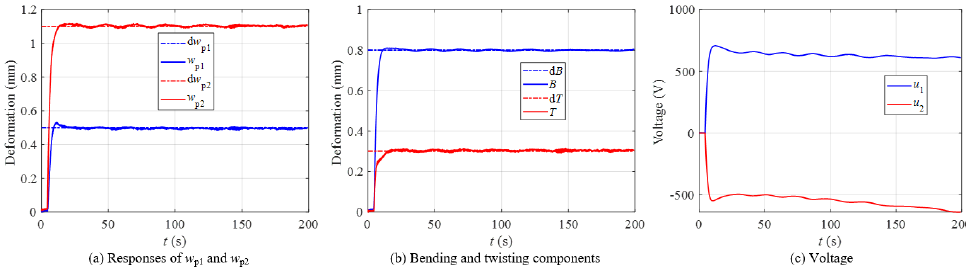
Figure 14. Arbitrary shape control performance. ( a ) The deflection histories of the two measurement points; ( b ) the time histories of B and T ; ( c ) the time histories of the voltages for the two MFC actuators.